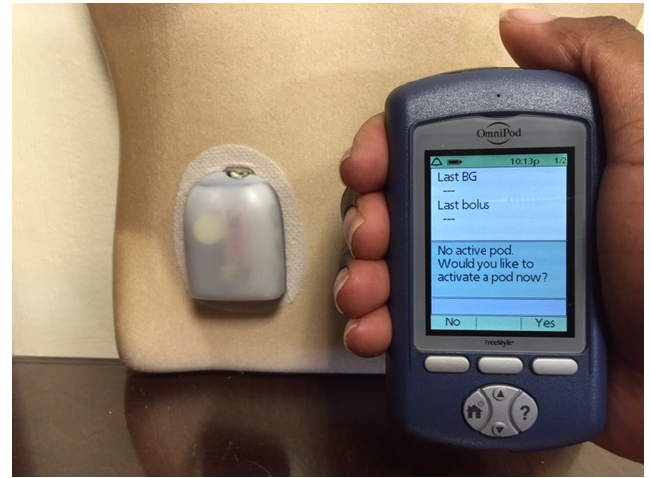
Figure 3. The OmniPod Tubeless Insulin Pump with a pod ( right ) and a handheld device that functions as a blood glucose meter and communicates wirelessly with the pod to deliver insulin based on the patient’s personal settings.